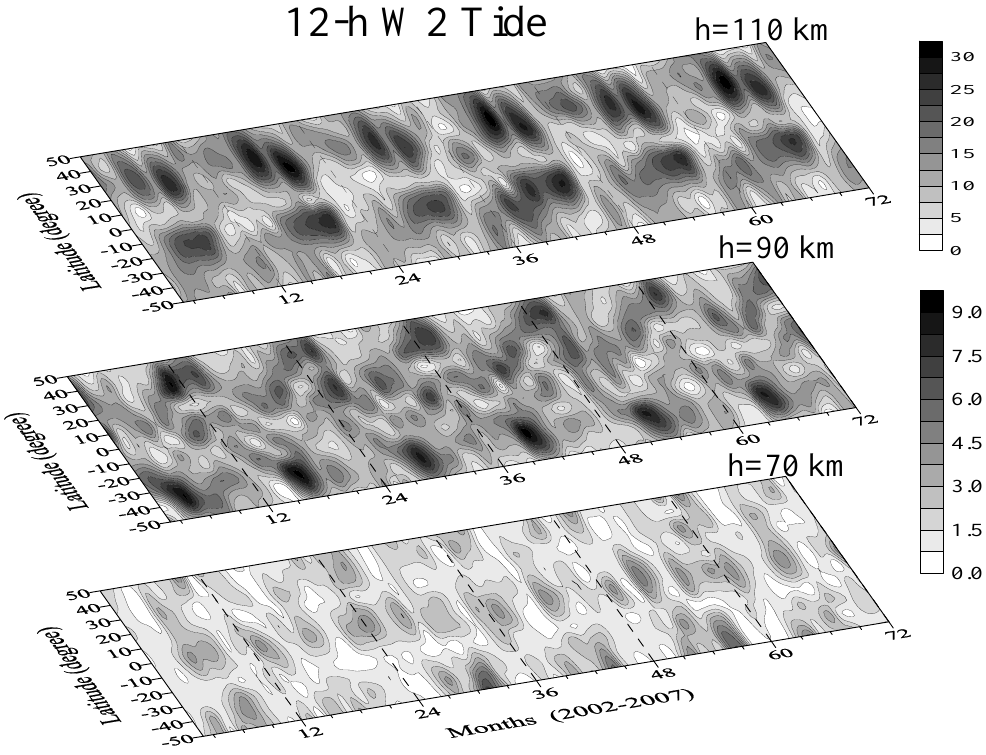
Figure 1 Fig. 1. Latitude-time cross sections of the semidiurnal tidal amplitudes (in Kelvin) at three altitudes: 110km (upper plot), 90km (middle plot) and 70km (bottom plot); the scale (in Kelvin) for the 110km level is different from that for 70km and